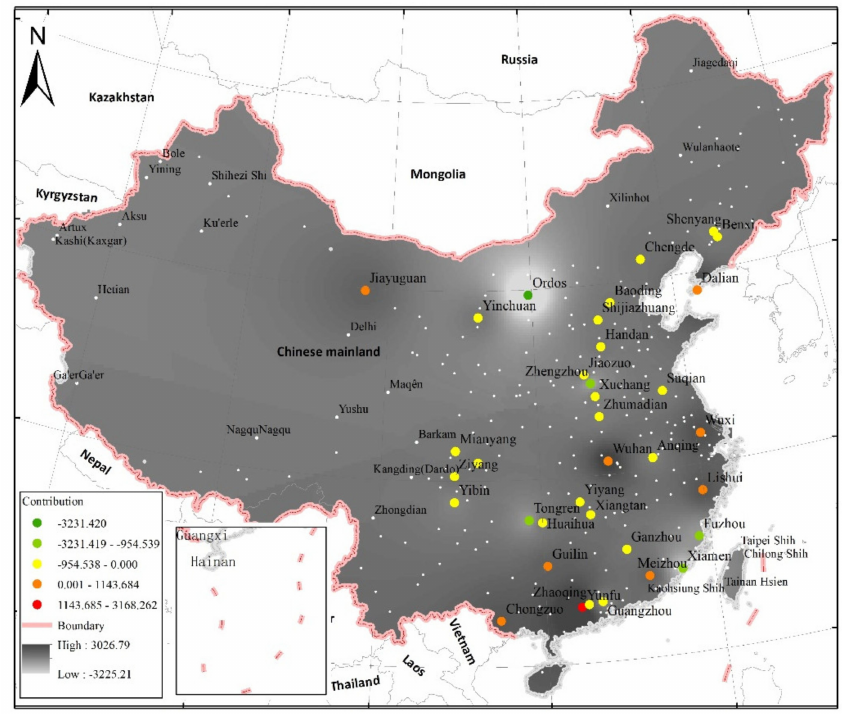
Figure A10. Contribution from the indicator PEI (proportion of education investment to the fiscal expenditure in the city) to land-use intensity revealed in the city-based assessment.